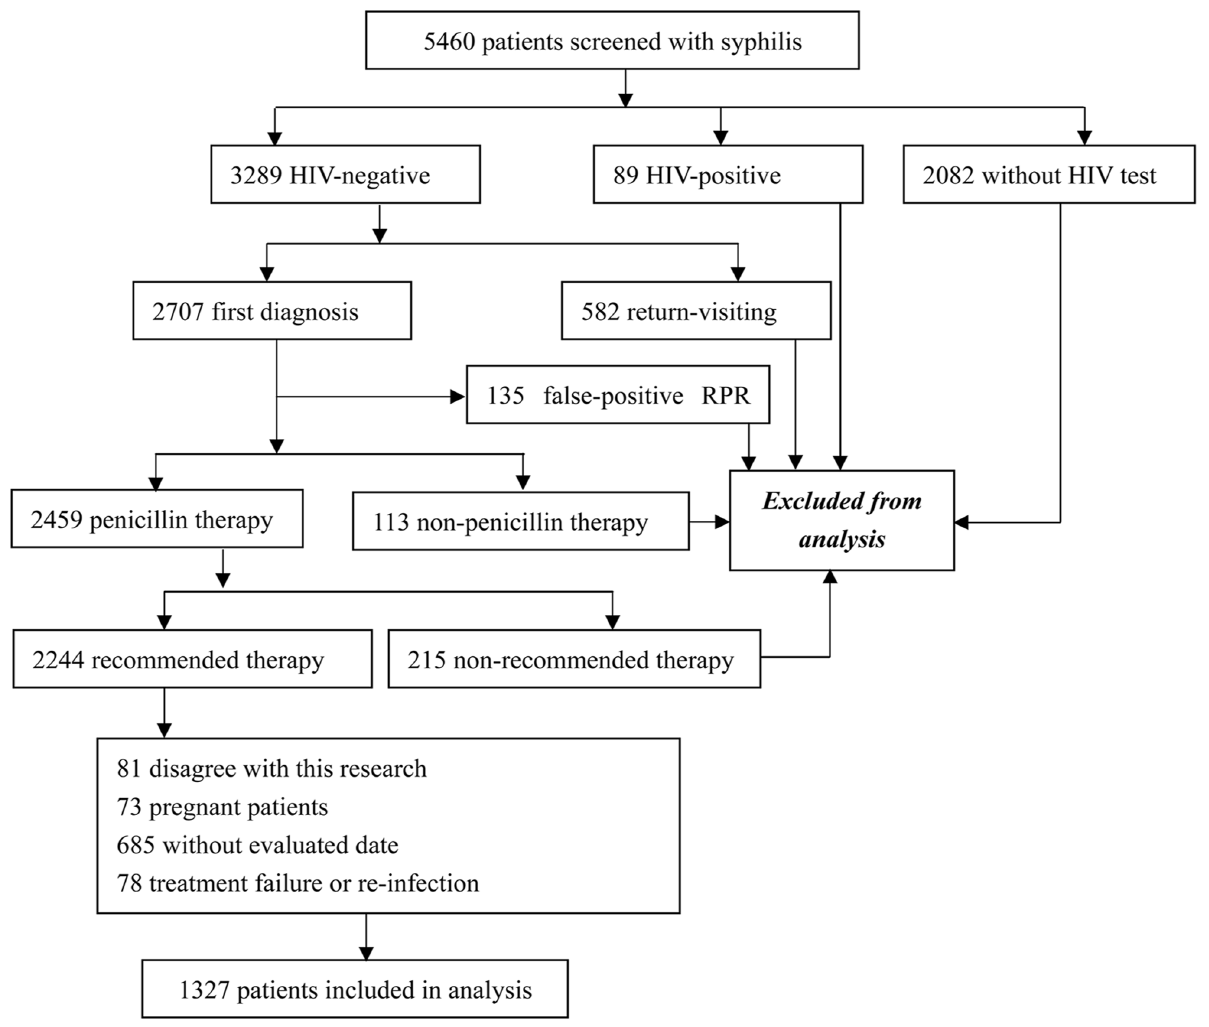
Figure 1. Patient selection criteria used in this study.